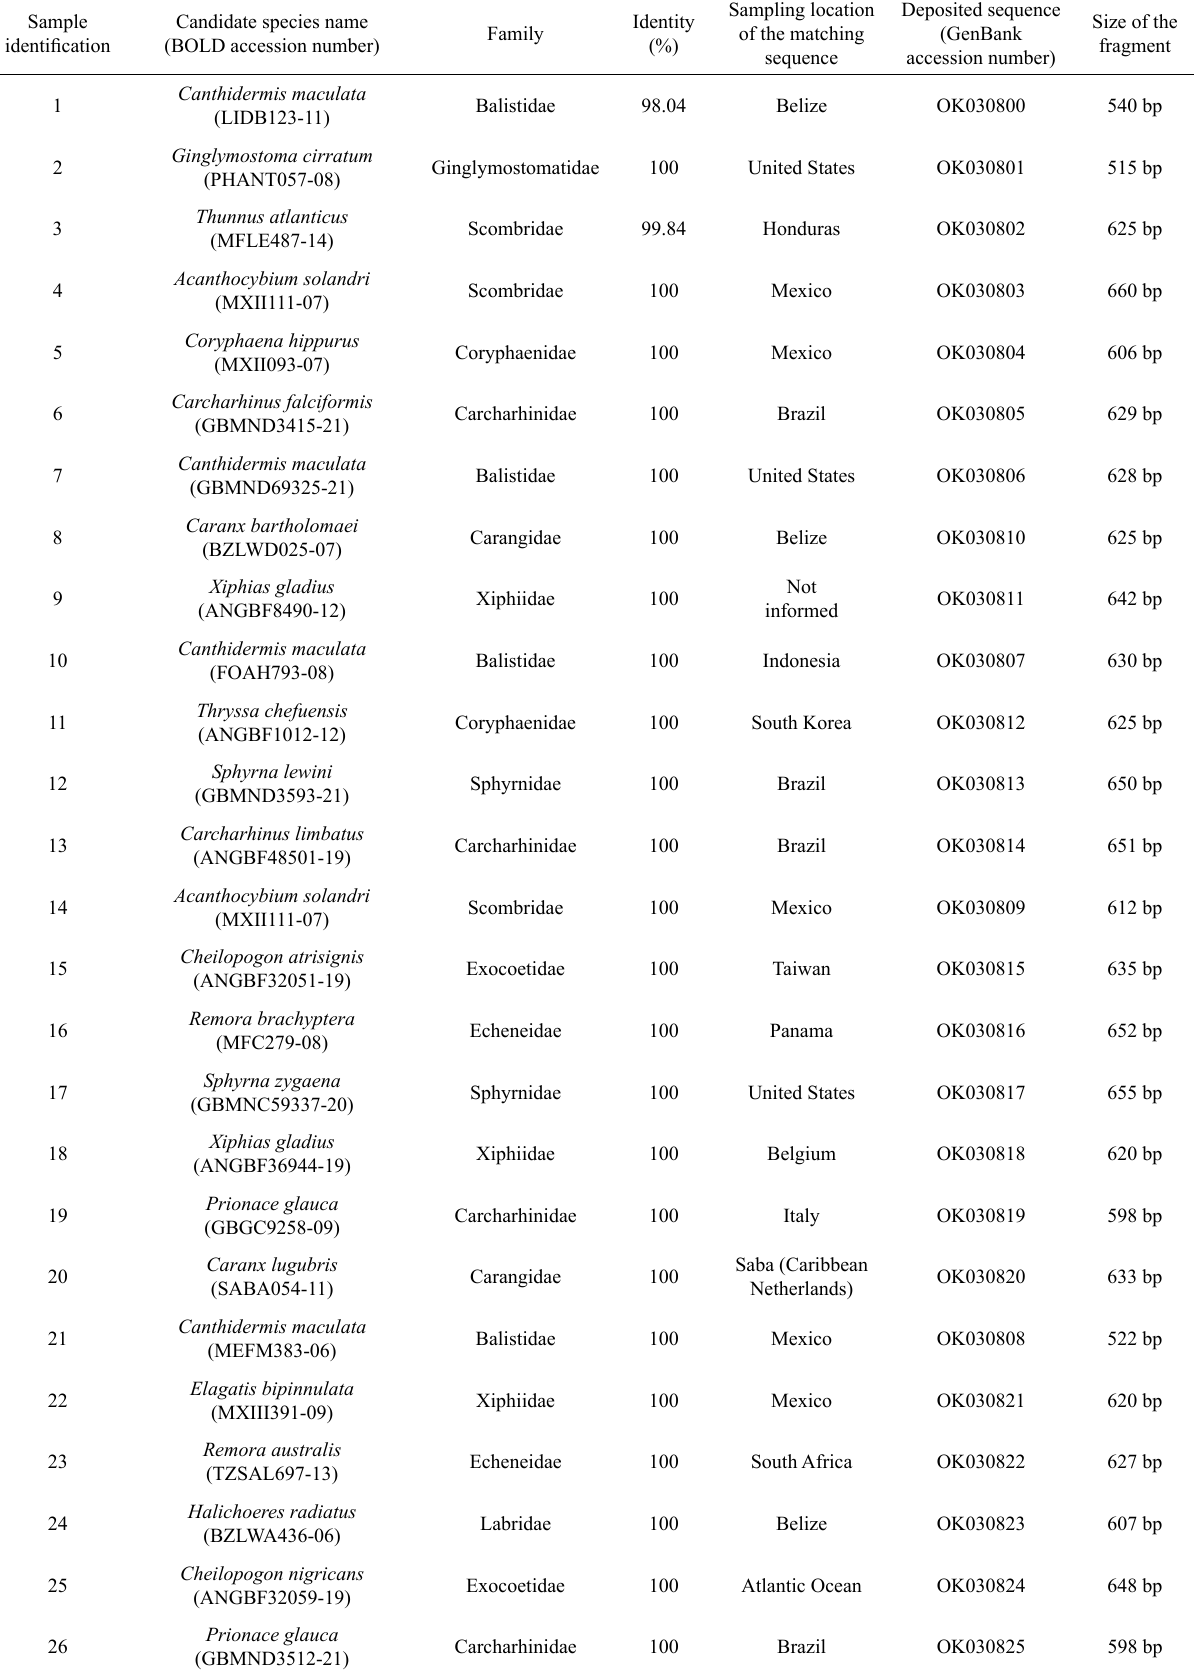
Table 1 – Sample identification, identified species, their family, similarity to the BOLD database candidate species (%), location of the BOLD matching sequence, deposited sequence (GenBank accession number), and size of the fragment. Identified fishes of Saint Peter and Saint Paul Archipelago. Sample